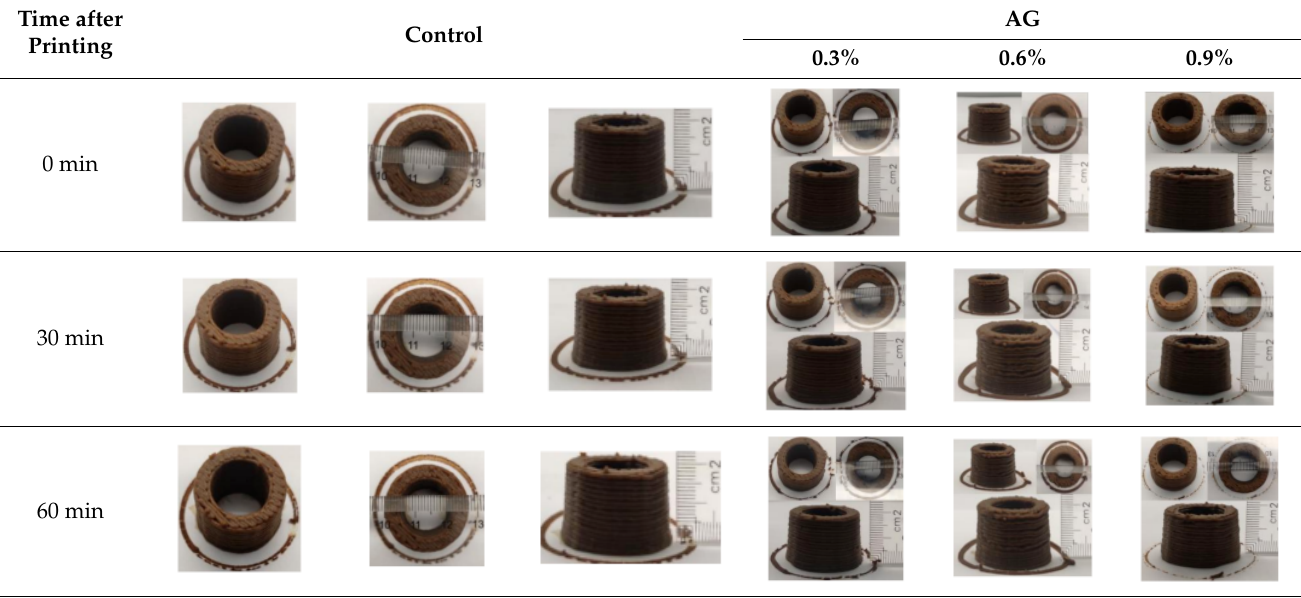
Table 4. The 3D printed samples with different formulation and storage